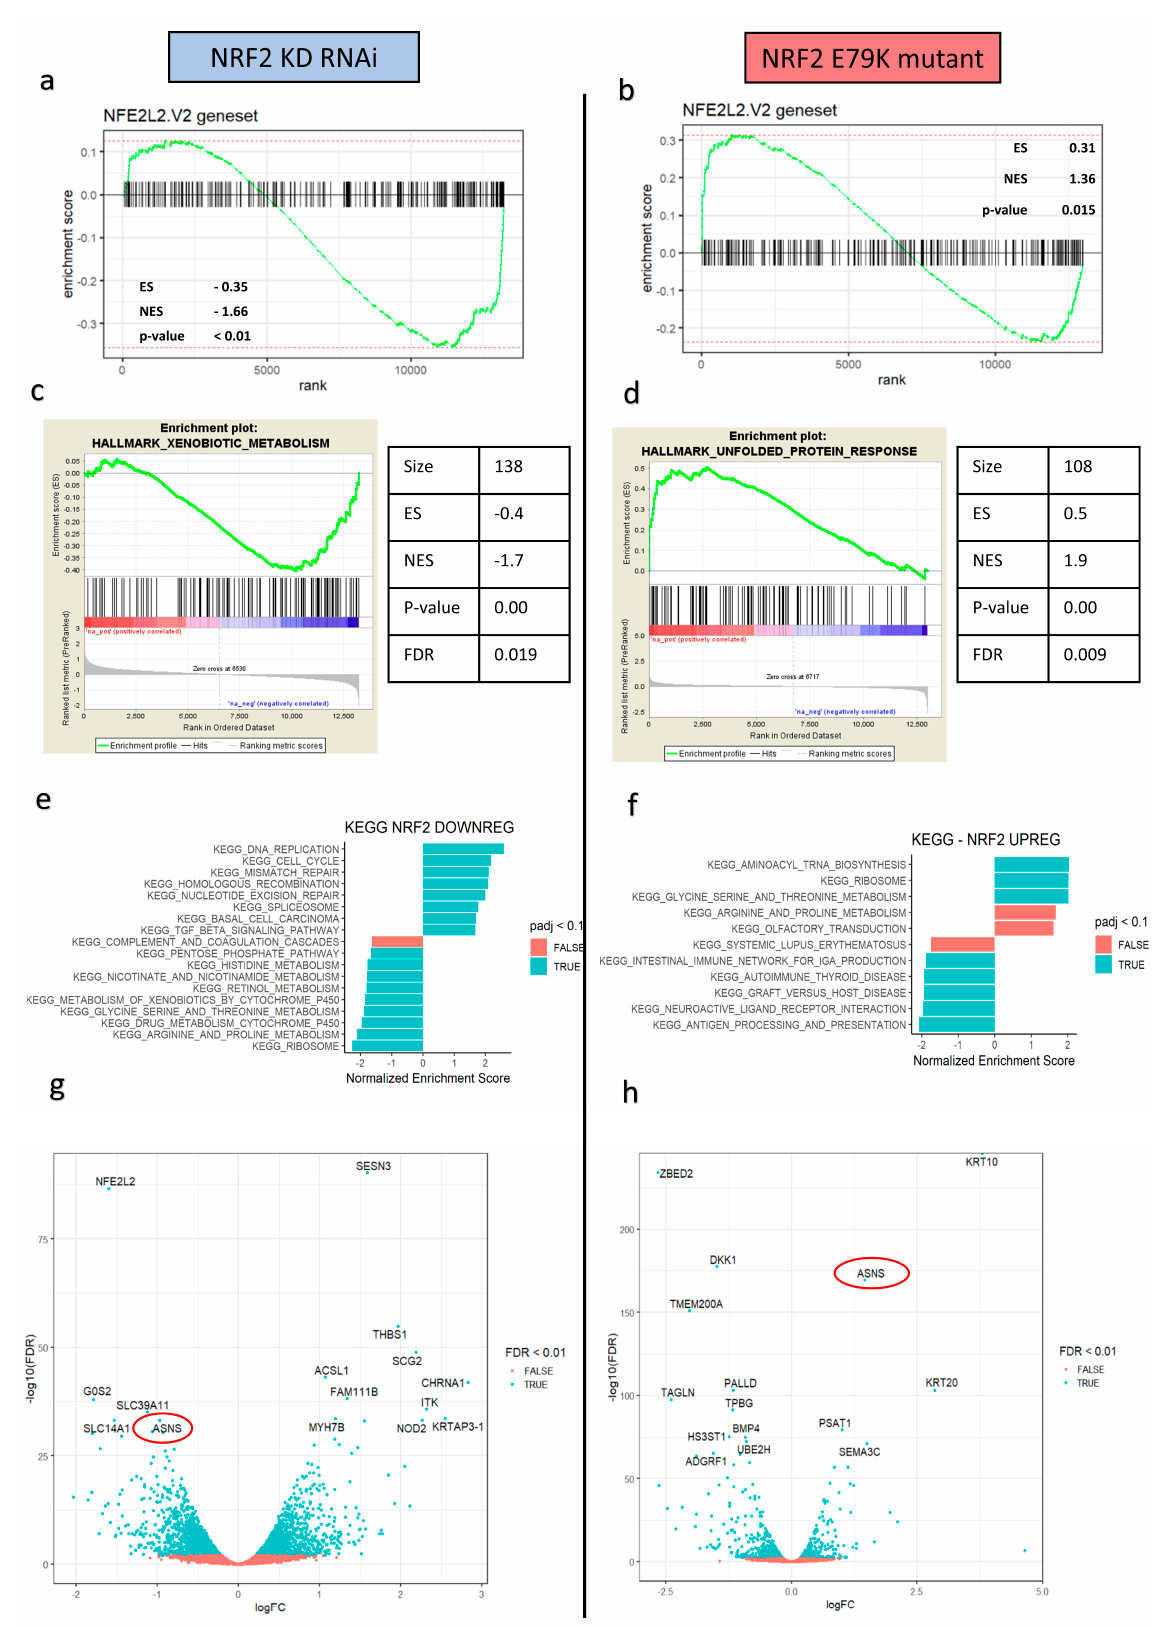
Figure 2. Downregulation and upregulation of NRF2 signalling result in opposing effects on tumour metabolism, particularly amino acid and protein metabolism. ( a ) GSEA enrichment plot for NFE2L2 targets in the ranked logFC of genes in the siRNA SW1463 model showing significant downregulation of NRF2 signalling; ( b ) GSEA enrichment plot for NFE2L2